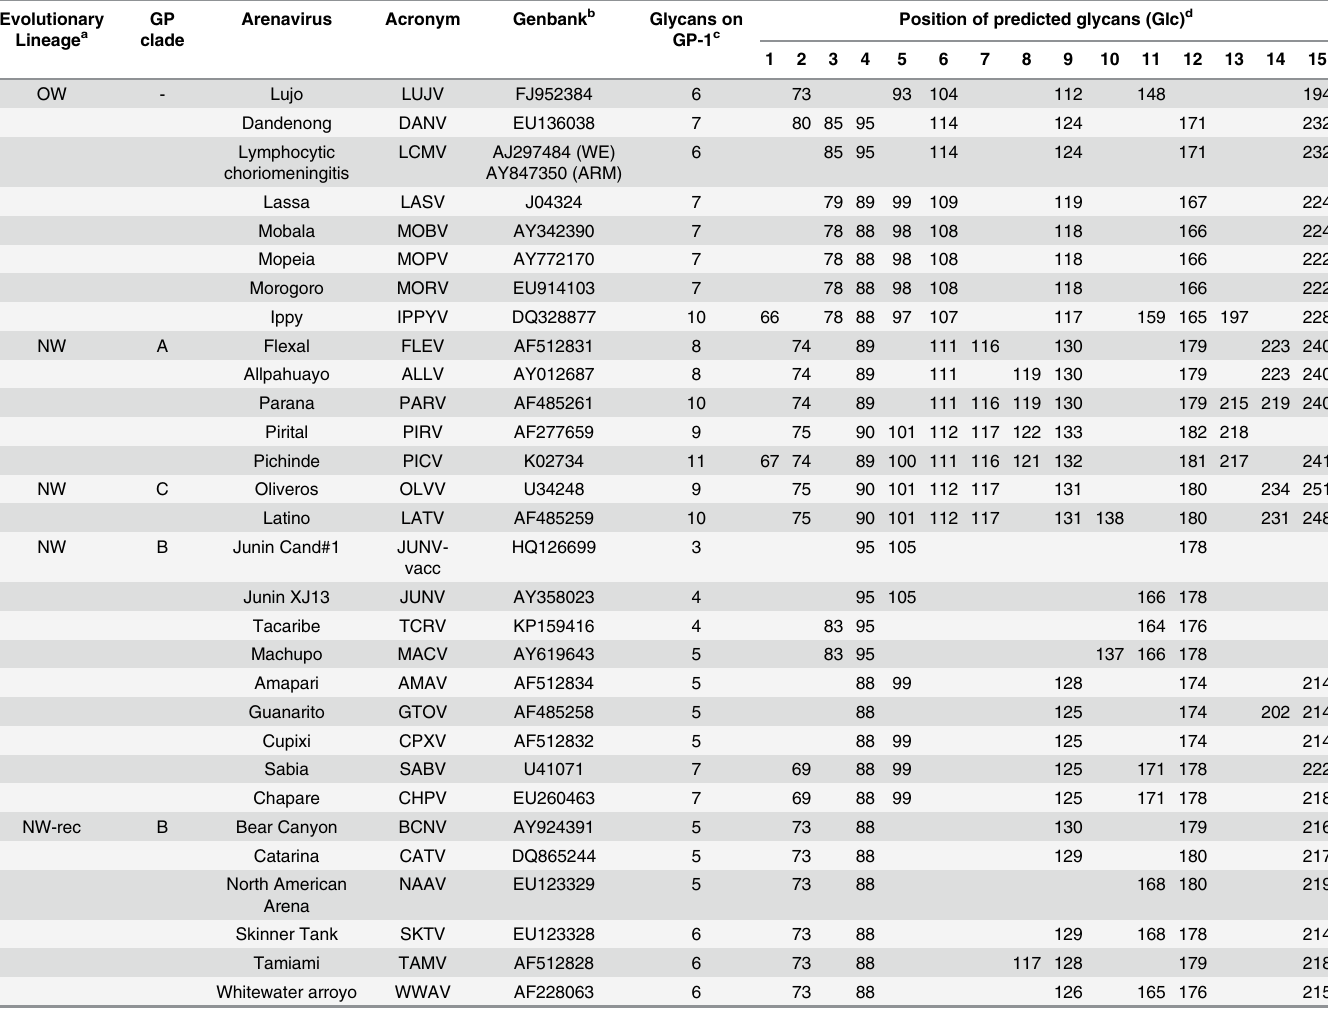
Table 1. N-linked glycosylation motifs in arenavirus GP-1